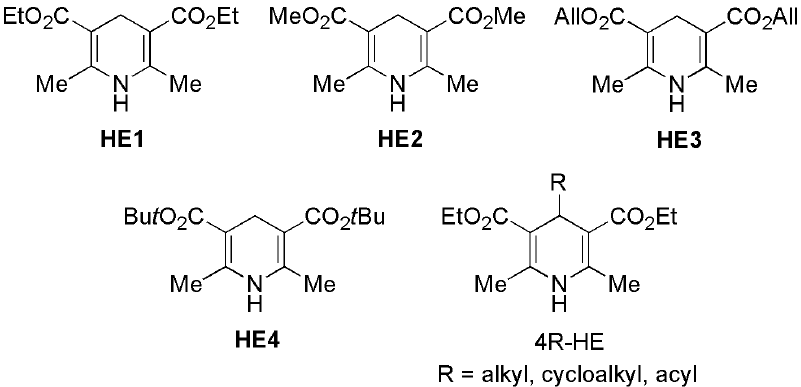
Figure 1. The Hantzsch esters most frequently used in enantioselective reactions during the period covered by this review.